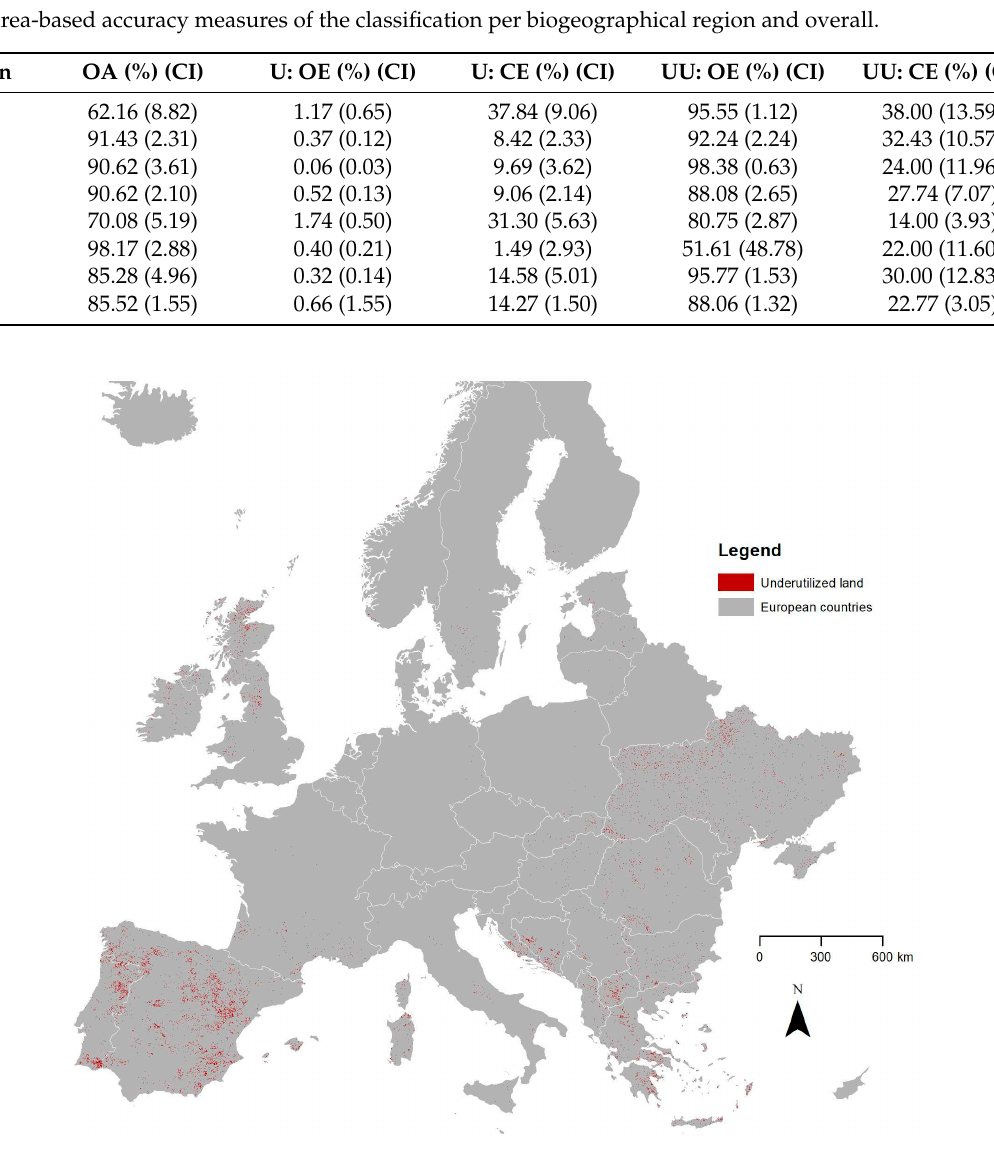
Figure 6. Final map of underutilized land in Europe.